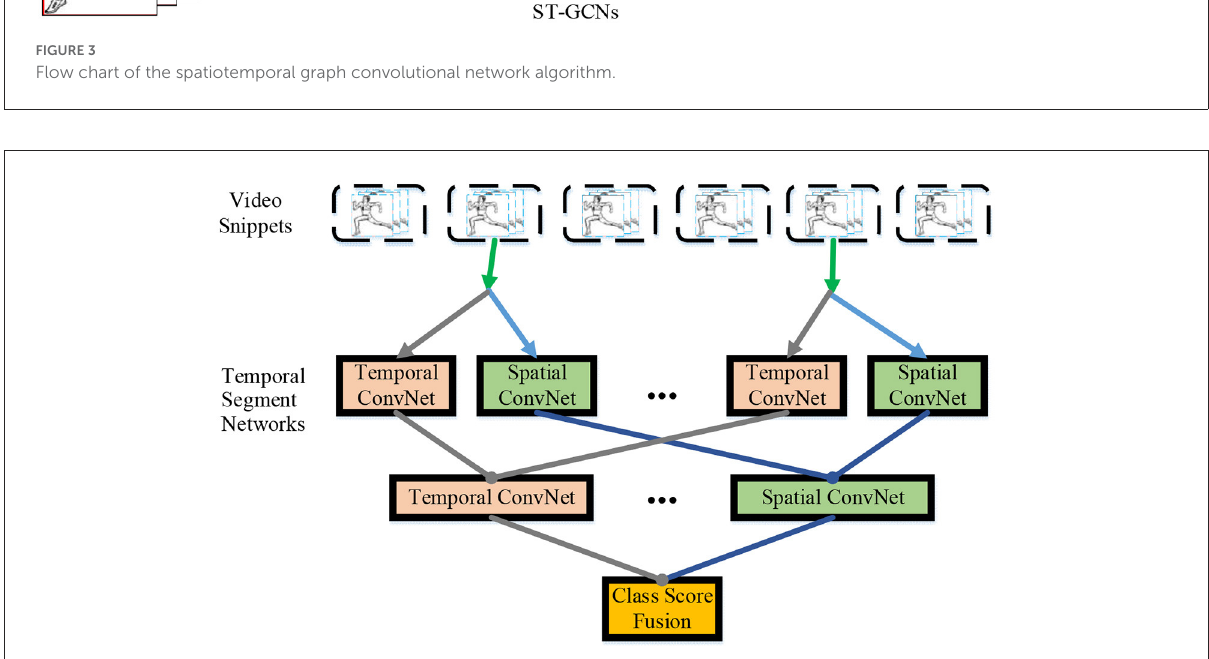
FIGURE4 Flowchart of the TSN